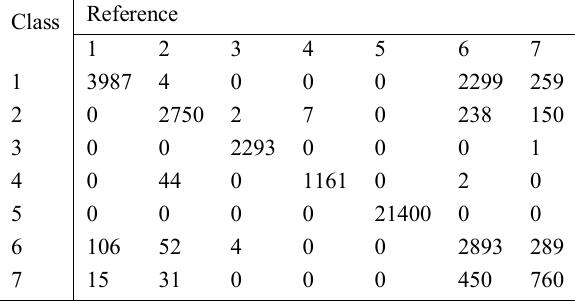
Table 7.1 Error matrix (pixel count) 2020 year